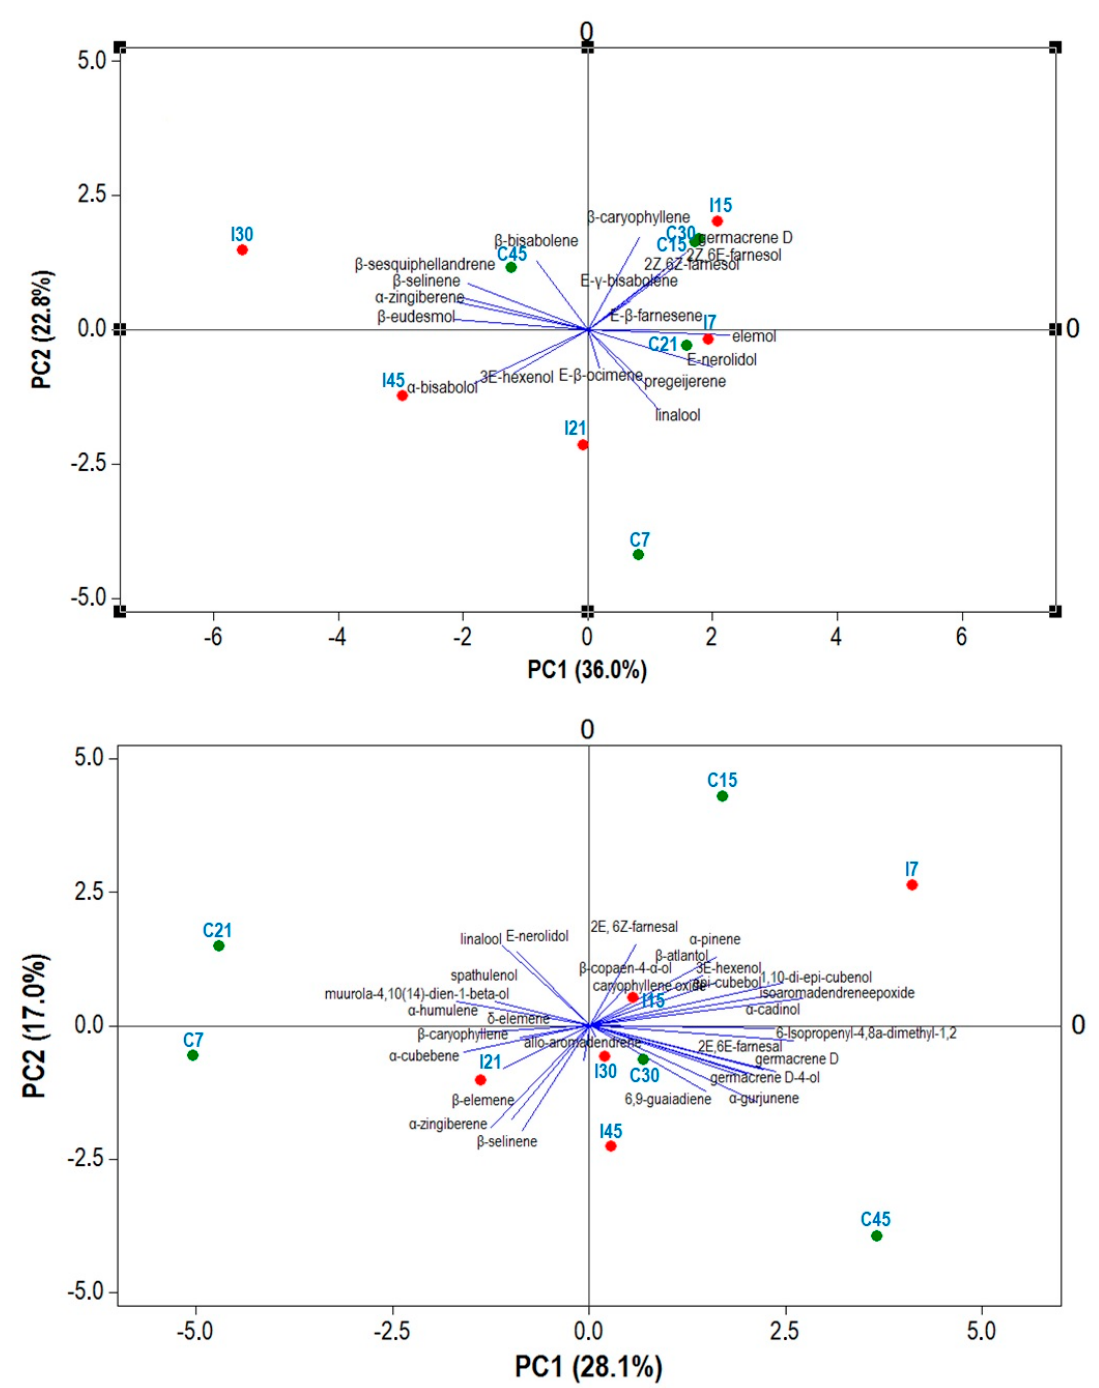
Figure 5. Bidimensional plot of first two components obtained by Principal Component Analysis (PCA) of P. nigrum cultivars based on Essential Oil (EO) chemical composition. Inoculated plants: I7, I15, I21, I30 and I45. Control Plants: C7, C15, C21, C30 and C45. ( A ) Bragantina; and ( B ) Cingapura. PC1: First Principal Component, PC2: Second Principal Component.